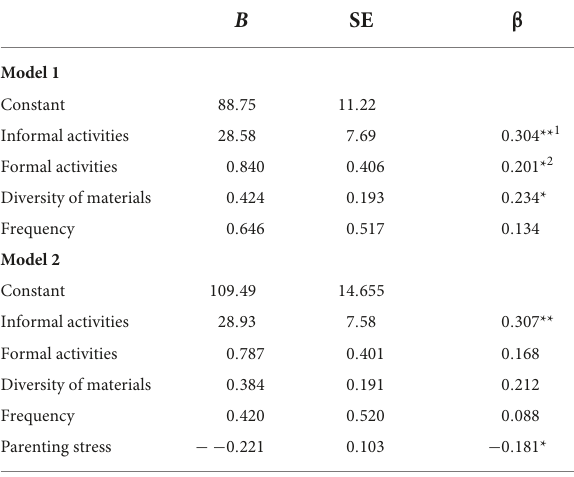
TABLE 2 Multiple regression analyses for reading